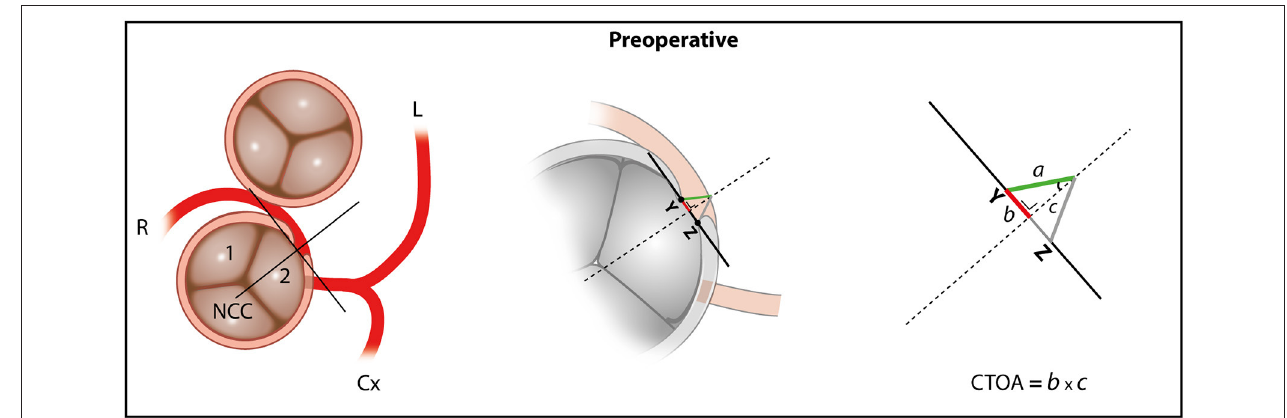
FIGURE 3 | Schematic representation of the coronary triangulated orifice area (CTOA). CTOA = 2 × ( ½ × b × c) = b × c; b = ½ ostial diameter; c = the depth of the triangle measured on CTA. The effective coronary ostial area as measured by the CTOA increases after the surgical correction of the coronary anomaly. R, right coronary artery; L, left coronary artery; Cx, circumflex coronary artery; NCC, non-coronary cusp; The area of the triangle is formed by 2 equilateral triangles. Y, representing the acute angle the outer edge of the orifice point; Z, representing the end of the ostium of the coronary anomaly; b, the base of the triangle; c, the depth of the triangle.